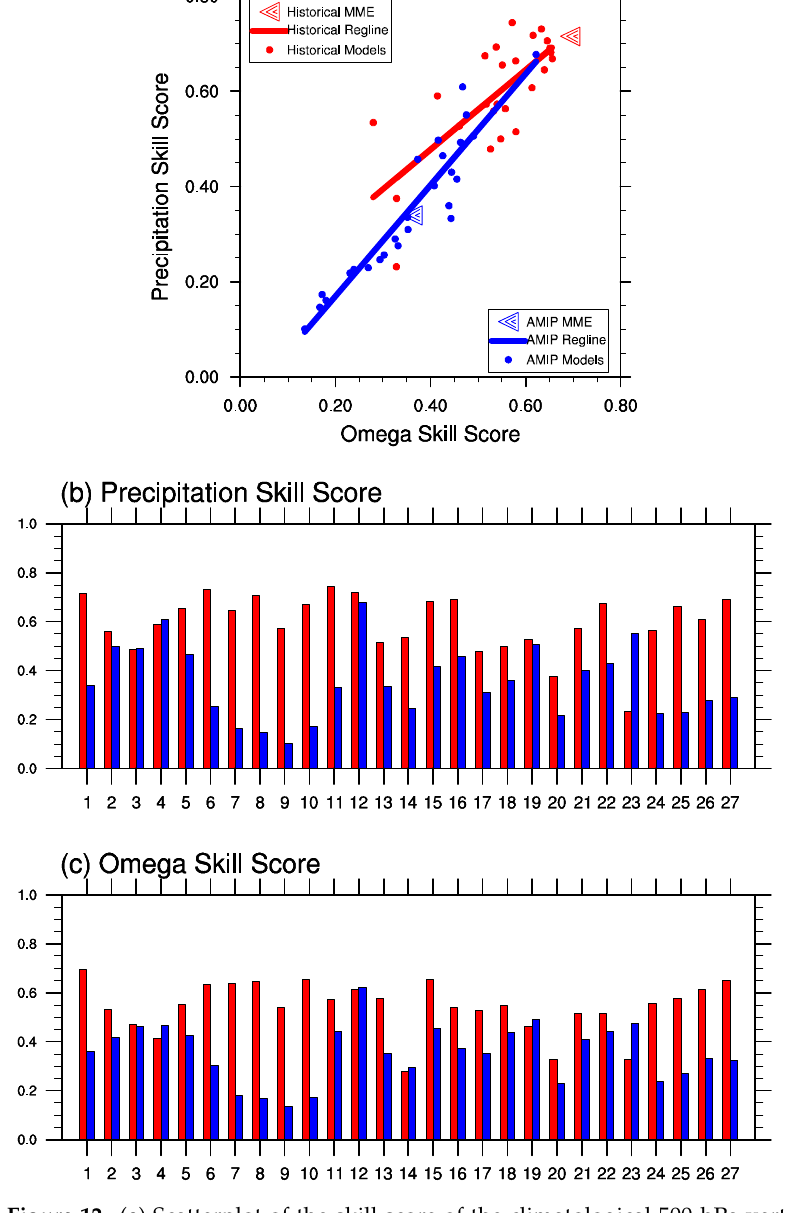
Figure 12. ( a ) Scatterplot of the skill score of the climatological 500-hPa vertical velocity change vs. precipitation change in the AMIP (blue) and historical (red) experiments. The skill scores for precipitation and 500-hPa vertical velocity in MME (labeled 1) and each model are shown in ( b ) and ( c ), respectively. The change means the difference between August and July.